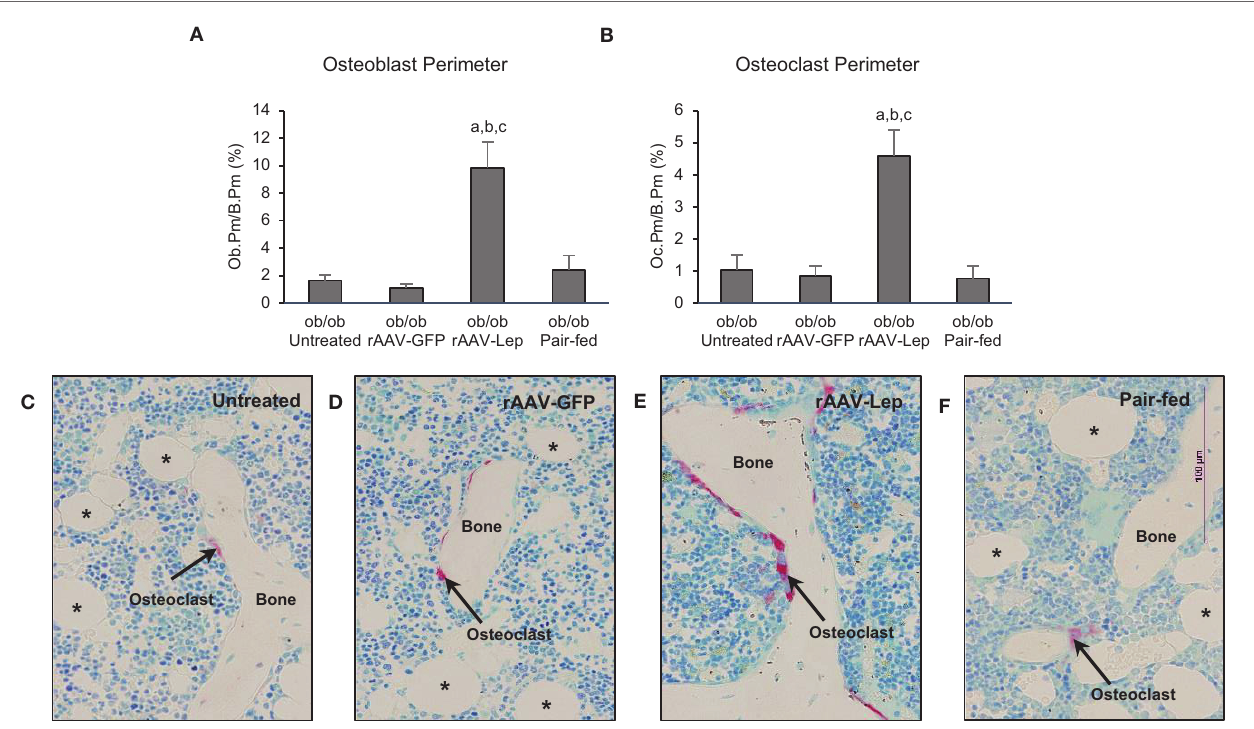
FigUre 2 | effects of hypothalamic leptin gene therapy (raaV-lep) on osteoblast perimeter, an index of bone formation, and osteoclast perimeter, an index of bone resorption, in distal femur metaphysis in male ob/ob mice at 30 weeks post-vector administration . Osteoblast perimeter (a) and osteoclast perimeter (B) were increased with rAAV-Lep treatment. The effects of treatment on osteoclast perimeter, an index of bone resorption, can be readily appreciated in representative micrographs from an untreated (c) , rAAV-GFP-treated (D) , rAAV-Lep-treated (e) , and pair-fed to rAAV-Lep (F) mouse. Data are mean ± SE ( n = 6–8/group). a Different from untreated, b different from rAAV-GFP, and c different from pair-fed, P < 0.05. Asterisks demarcate